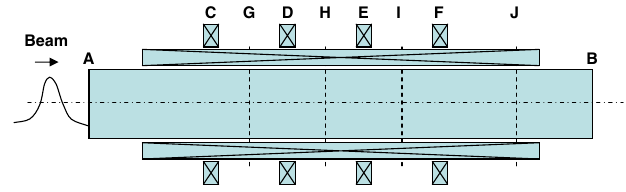
FIG. 8. Geometry of simulation in Sec. IV